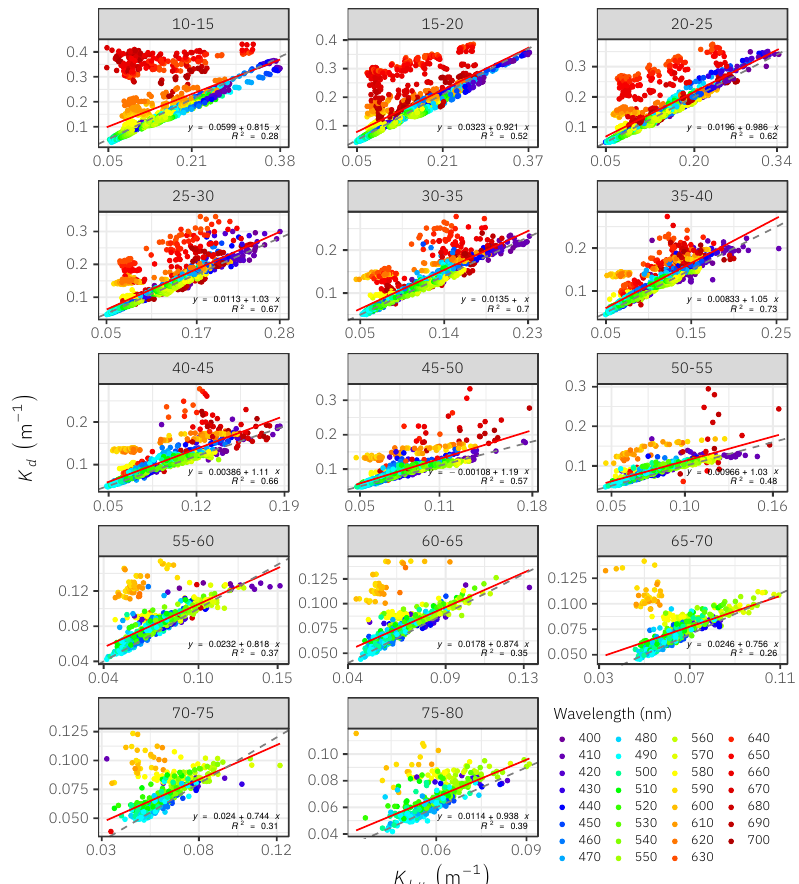
Figure A3. Scatter plots showing the relationships between downward irradiance ( E d ( z ) ) and upward radiance ( L u ( z ) ) between 400 and 700 nm at different depths (numbers in gray boxes). Red lines represent the regression lines of the fitted linear models. Dashed lines are the 1:1 lines. Note the large deviations between the data points and the 1:1 line occurring in the orange and red regions ( ≥ 600 nm).